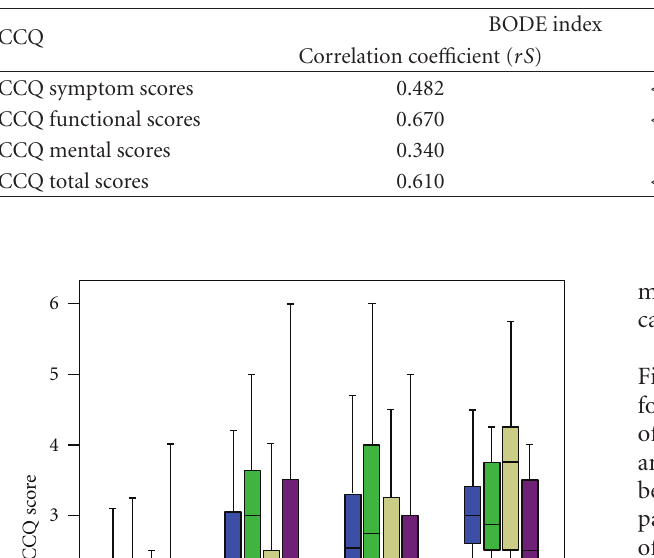
Table 4: Spearman correlation between CCQ scores and the BODE index/GOLD classification in assessment of severity of COPD.